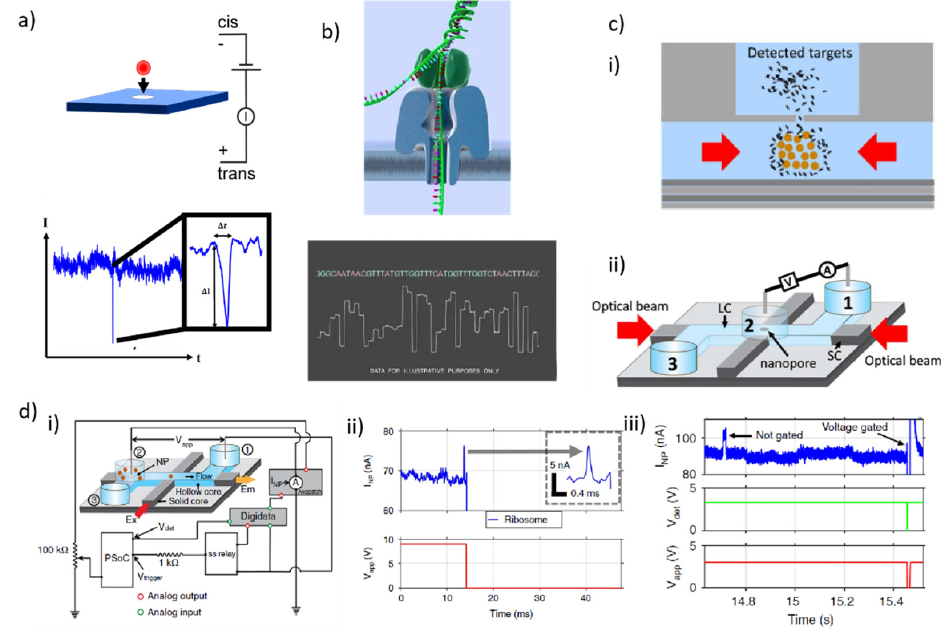
Figure 8. ( a ) Schematic illustration of the nanopore working principle and detection signal [14]. ( b ) The principle of nanopore-based nucleic acid sequencing [389]. ( c ) Trap-assisted capture rate enhancement of a nanopore [422]. ( i ) A cartoon depicting the conceptual visualization of TACRE. ( ii ) Schematic illustration of the experimental setup. ( d ) On-demand target delivery on a programmable ARROW optofluidic device [275]. ( i ) Schematic illustration with feedback control mechanisms. ( ii ) Current (top) and voltage (bottom) trace of a voltage gated single ribosome delivery. ( iii ) Current (top), identification signal (middle), and voltage (bottom) trace of identification and voltage gating of only λ -DNAs from a mixture of λ -DNA and ribosome.